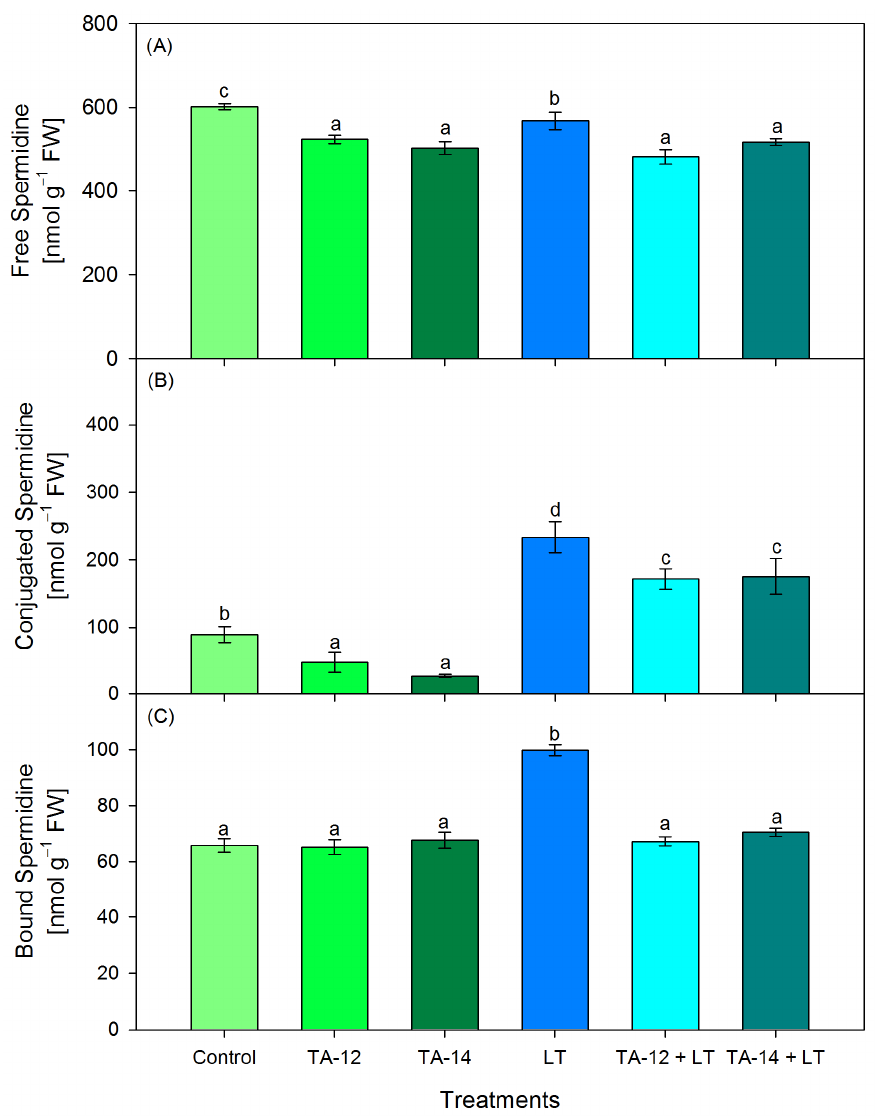
Figure 4. Content of free ( A ), conjugated ( B ) and bound ( C ) spermidine (Spd) in pea sprayed with TA-12 or TA-14 and subjected to low temperature (−1 °C, LT) for 24 h. Data are mean values ± SE. Different letters designate statistically significant difference at p < 0.05.